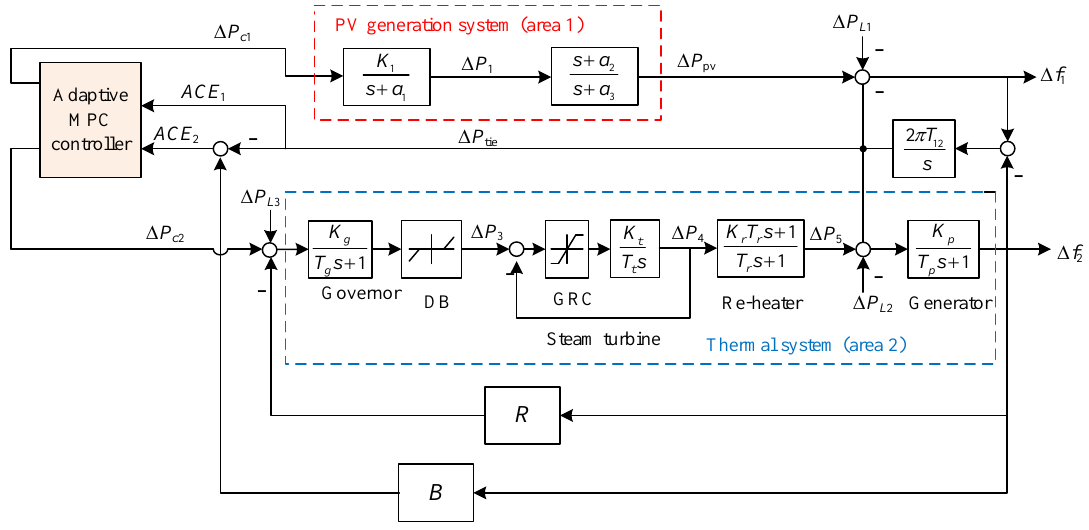
Figure 1. The block diagram of a two-area interconnected power system composed of photovoltaic and thermal generator.